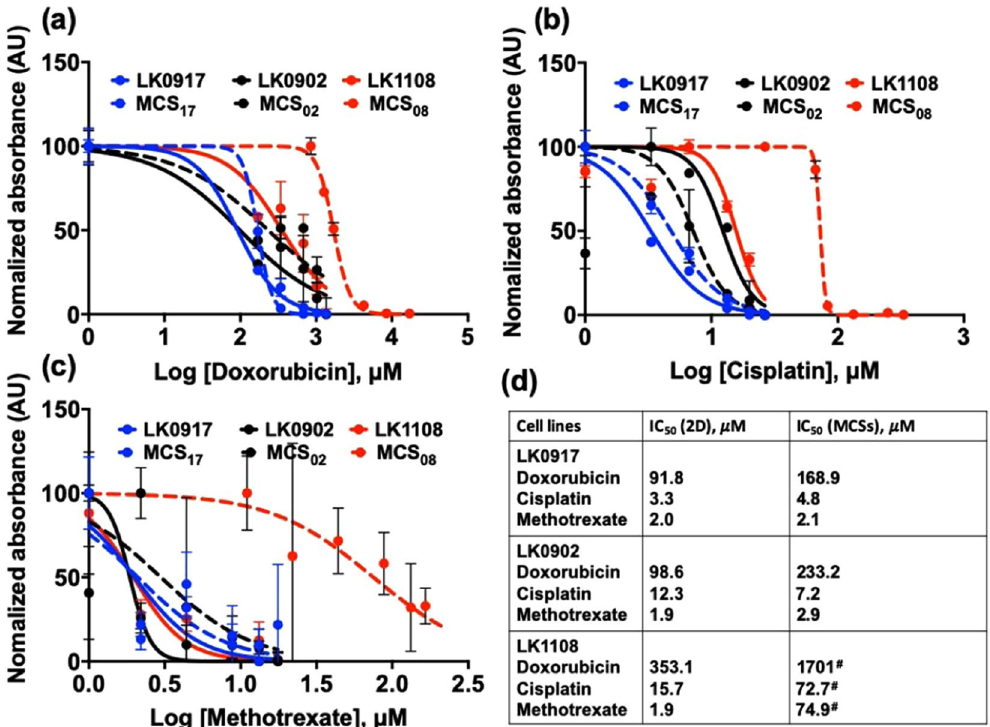
Figure 3. Comparative drug response profiles of 2D cell cultures and MCSs. ( a – c ) Drug response curves for LK0917, LK0902, and LK1108 for 2D and MCSs cultures treated with 170–17000 µ M of doxorubicin; 3.33– 333 µ M of cisplatin; and 2.2–220 µ M of methotrexate. ( d ) IC 50 ( µ M) values calculated from the drug response curves for both 2D and MCSs of all cell types for all drugs. Significantly large differences between the IC 50 values of 2D and MCSs are denoted with “ # ”. Each IC 50 value is the average of three independent experiments (n = 3) with triplicates set for each